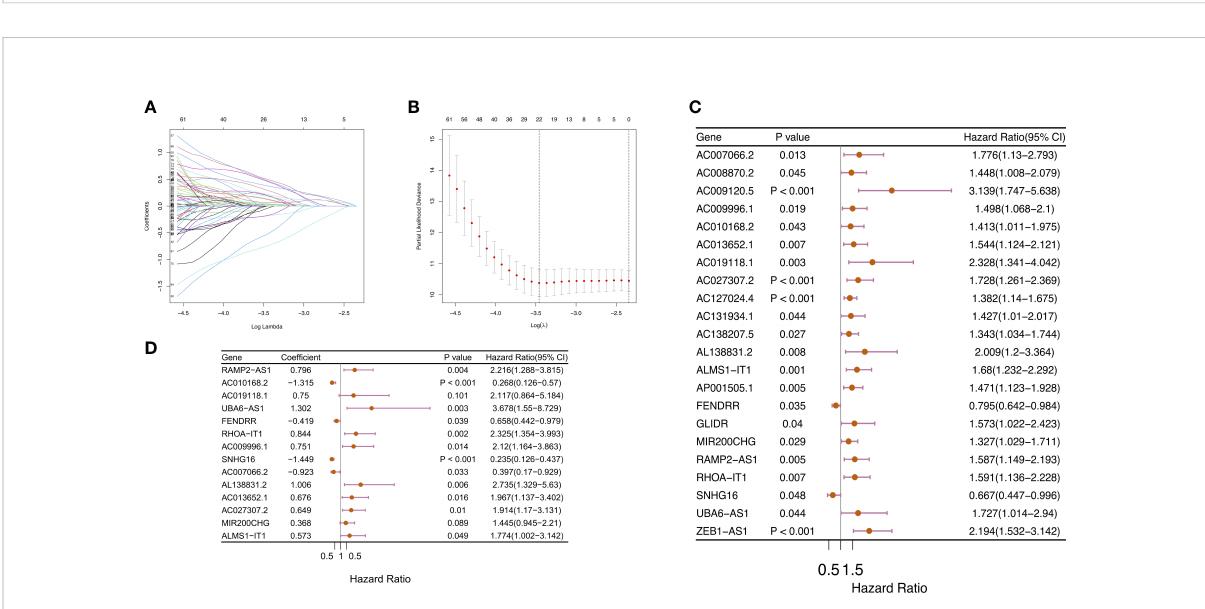
FIGURE 5 Construction of m6ALncSig for patients with COAD. (A – C) LASSO-penalized COX regression analysis selected 22 m6A-related lncRNA remarkably associated with OS. (D) Multivariate Cox regression analysis revealed 14 independent prognostic